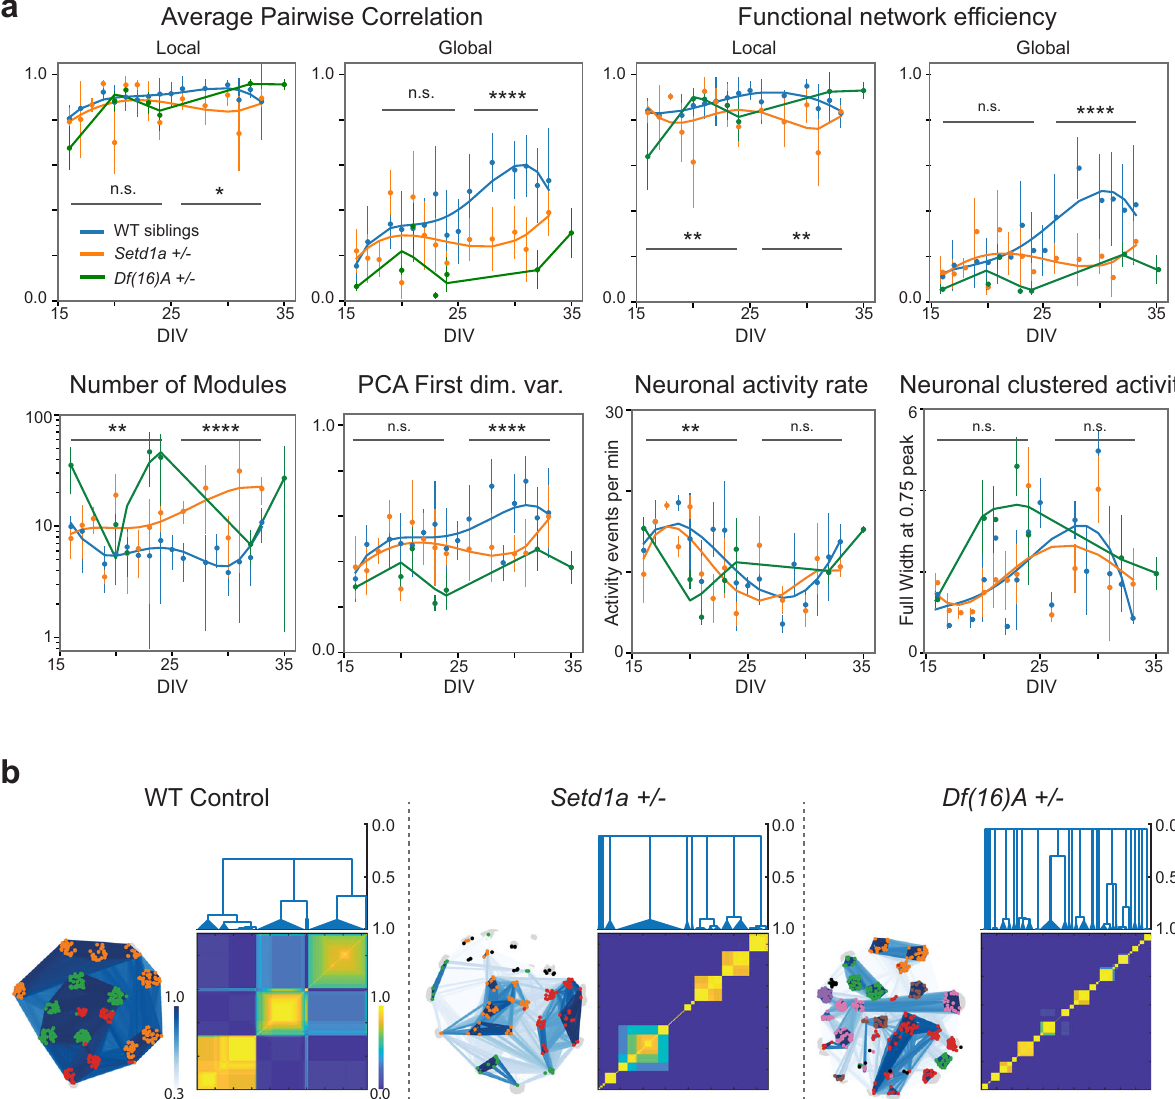
Fig. 5 Characterization of in vitro models of SCZ-associated network pathophysiology. a Comparison of various local and global quantitative measures of MoNNets derived from Setd1a + / − (orange), WT siblings(blue) and Df(16)A + / − (green): average pairwise correlation, global ef fi ciency of functional weighted graphs, number of detected modules, activity data variance captured by the fi rst PCA dimension, predicted activity-onset events rate per minute; full width at 75% of the maximum peak of ∂ F/F traces. Statistical signi fi cance was calculated by comparing pooled data (black bars) of Setd1a + / − vs. WT siblings. Statistical signi fi cance (two-sided t-test) is de fi ned as: * p < 0.05, ** p < 0.01, *** p < 0.001, **** p < 0.0001. For WT control siblings, 272 different MoNNet samples were imaged. Note that each sample was only imaged once to minimize image acquisition associated artefacts and non-active samples were fi ltered. Biologically independent samples (n) across DIVs in graph as follows. n (16): 12, n (17): 6, n (19): 7, n (20): 8, n (21): 14, n (22): 13, n (23): 12, n (24): 14, n (25): 6, n (26): 7, n (28): 7, n (29): 8, n (30): 6, n (31): 9, n (32): 9, n (33): 5. For Setd1a + / − 158 different MoNNet samples were imaged. Each sample was only imaged once, and non-active samples were fi ltered. Biologically independent samples (n) across DIVs in graph as follows. n (16): 12, n (17): 5, n (18): 3, n (19): 6, n (20): 8, n (21): 6, n (22): 14, n (23): 12, n (24): 5, n (26): 5, n (28): 5, n (30): 7, n (31): 7, n (33): 3. For Df(16)A + / − , 58 different samples were imaged. Each individual sample was imaged only once and non-active samples were fi ltered. Biologically independent samples (n) across DIVs in graph as follows. n (16): 4, n (20): 3, n (21): 9, n (23): 4, n (24): 8, n (32): 8, n (35): 4. b Representative examples of comparing hierarchical modular organization. Nodes belonging to same module are colored same. Co-classi fi cation matrix heatmap and clustering dendograms are shown to visualize hierarchical relationship. For all plots, mean and std. deviation are plotted. Also see Supplementary Fig. 11 and Video 8. Source data are provided as a Source Data fi